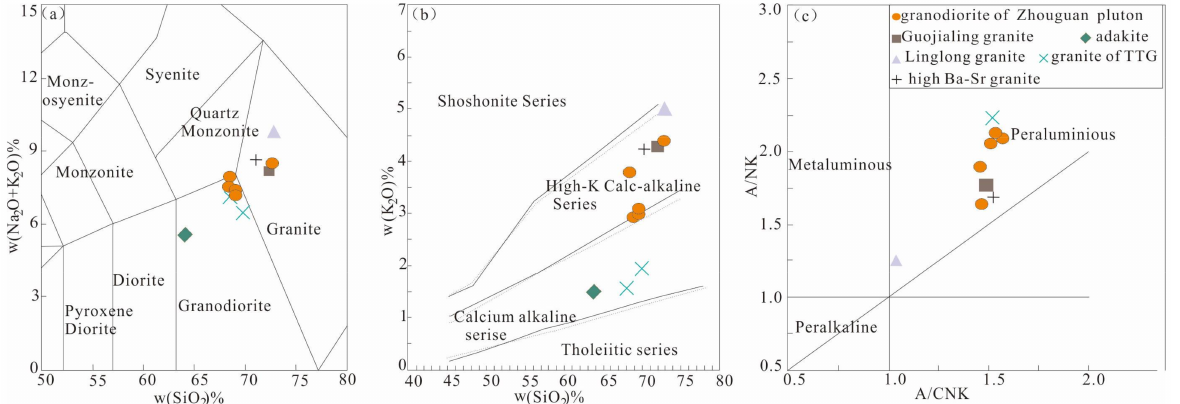
Figure 3. Variation diagram of the major elements in the Zhouguan granodiorite. ( a ) Diagram of